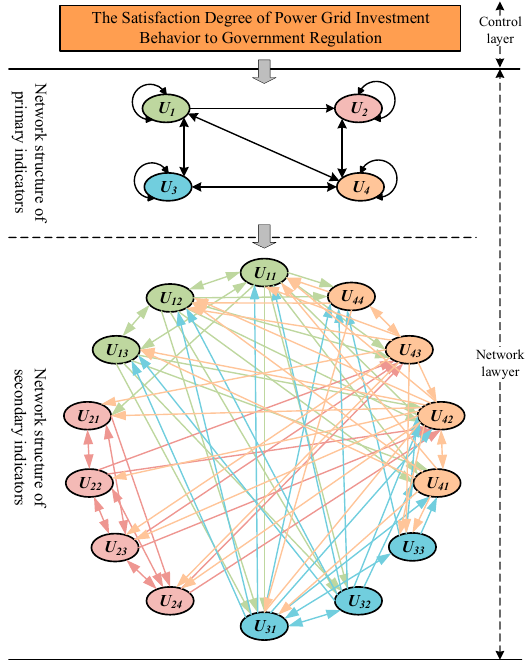
Figure 2. Network hierarchy of the index system.